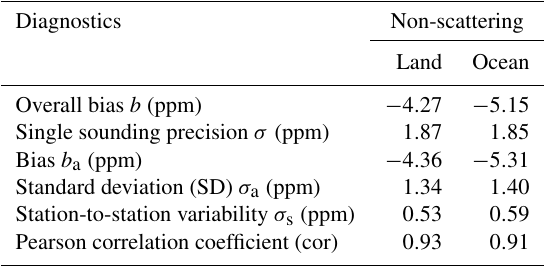
Table 4. Similar to Table 3 but for non-scattering retrievals using the 2 . 06µm band. Here, we use the same cases as one-band retrievals in Table